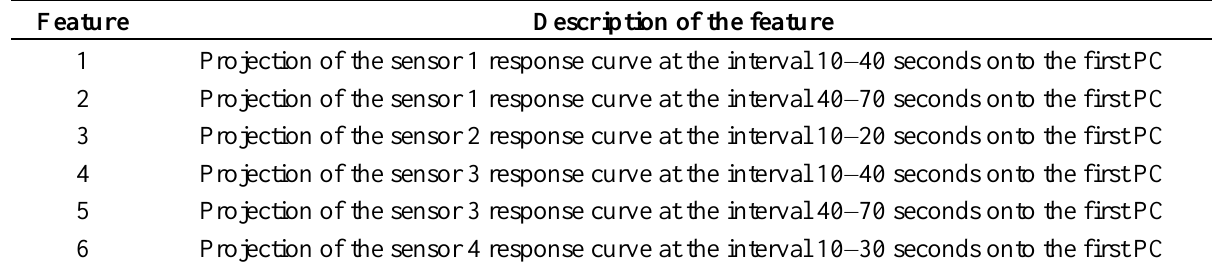
Table 2. Definition of the characteristic vector representative of the measurements.